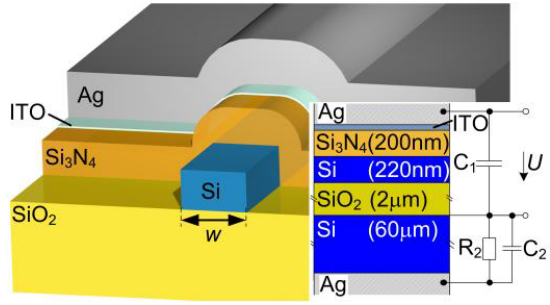
Figure 12: (A) Schematic of the waveguide-integrated silicon-based nanophotonic modulator. (B) Electric field density across the active MOS region of the modulator. (C) Experimentally demonstrated ER up to 1 dB/ µ m. Copyright (2012), Walter de Gruyter, from Ref.